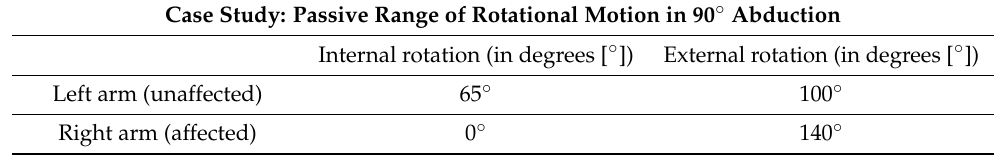
Figure 6. Case study: Active range of rotational motion of the affected shoulder. Table 1. Case report: Passive range of rotational motion in 90 ◦ of shoulder